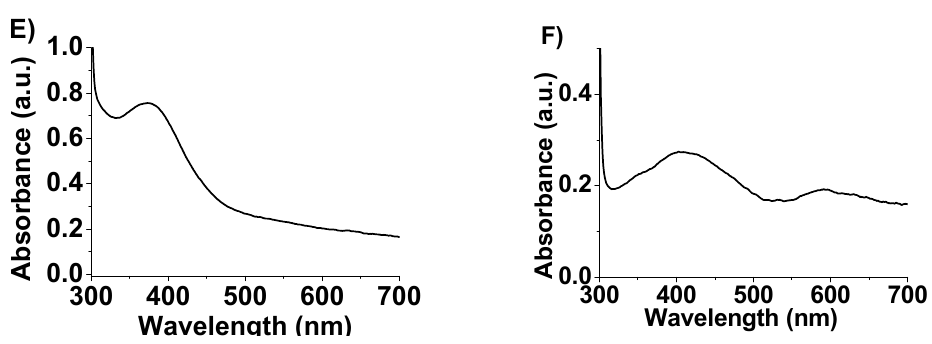
Figure 5. UV-Vis absorbance spectra of dye-CNHs 1 – 6 ( A – F ) in 1,2-dichlorobenzene.